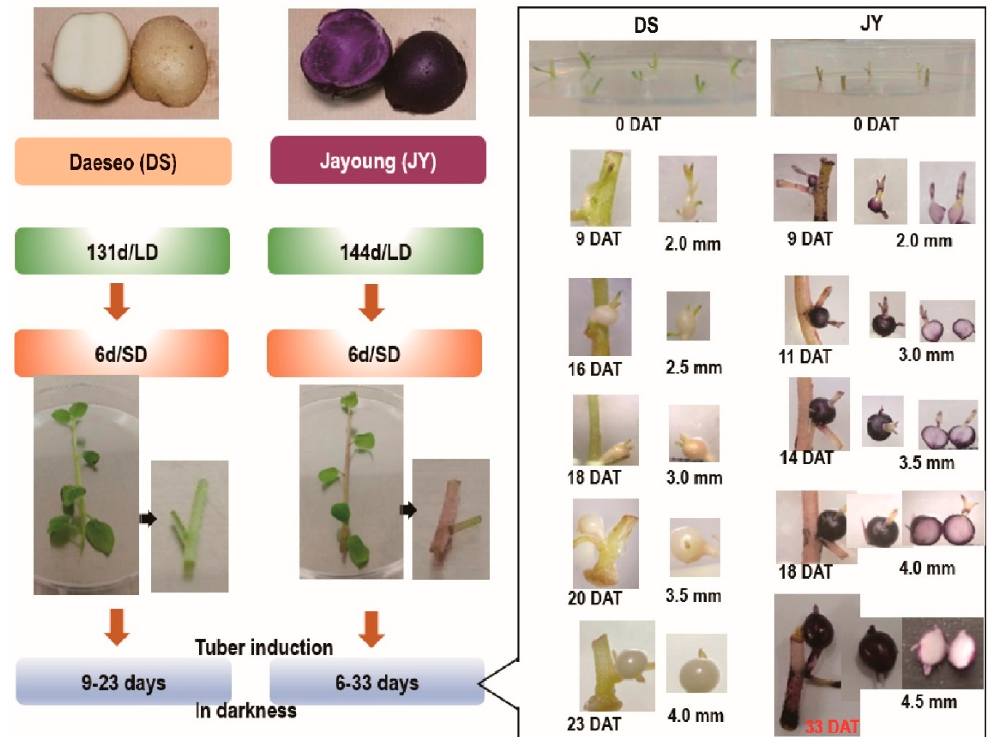
Figure 1. Tuber induction (TI) process from single-node cuttings and phenotypes of each stage. DS (‘Daeseo’) and JY (‘Jayoung’) tissue cultures were kept for 131 days and 144 days, respectively, under long-day conditions (16 h light /8 h dark) in a culture room set to 22 ± 0.5 °C and 110 µmol m − 2 s − 1 light intensity. Then, plants were transferred to short-day (SD) conditions (8 h light /16 h dark) for 6 days before preparing a single node. Tuber induction was performed in darkness for the indicated days. Tuber diameters are expressed as mm, and JY tubers were cross-sectioned to show anthocyanin accumulation. DAT indicates day after transfer to darkness. Single-node cuttings on induction medium are shown at 0 DAT.